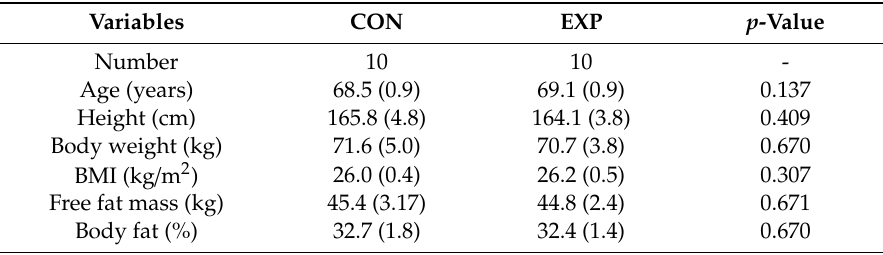
Table 1. Selected participant characteristics. Data are means ( ±